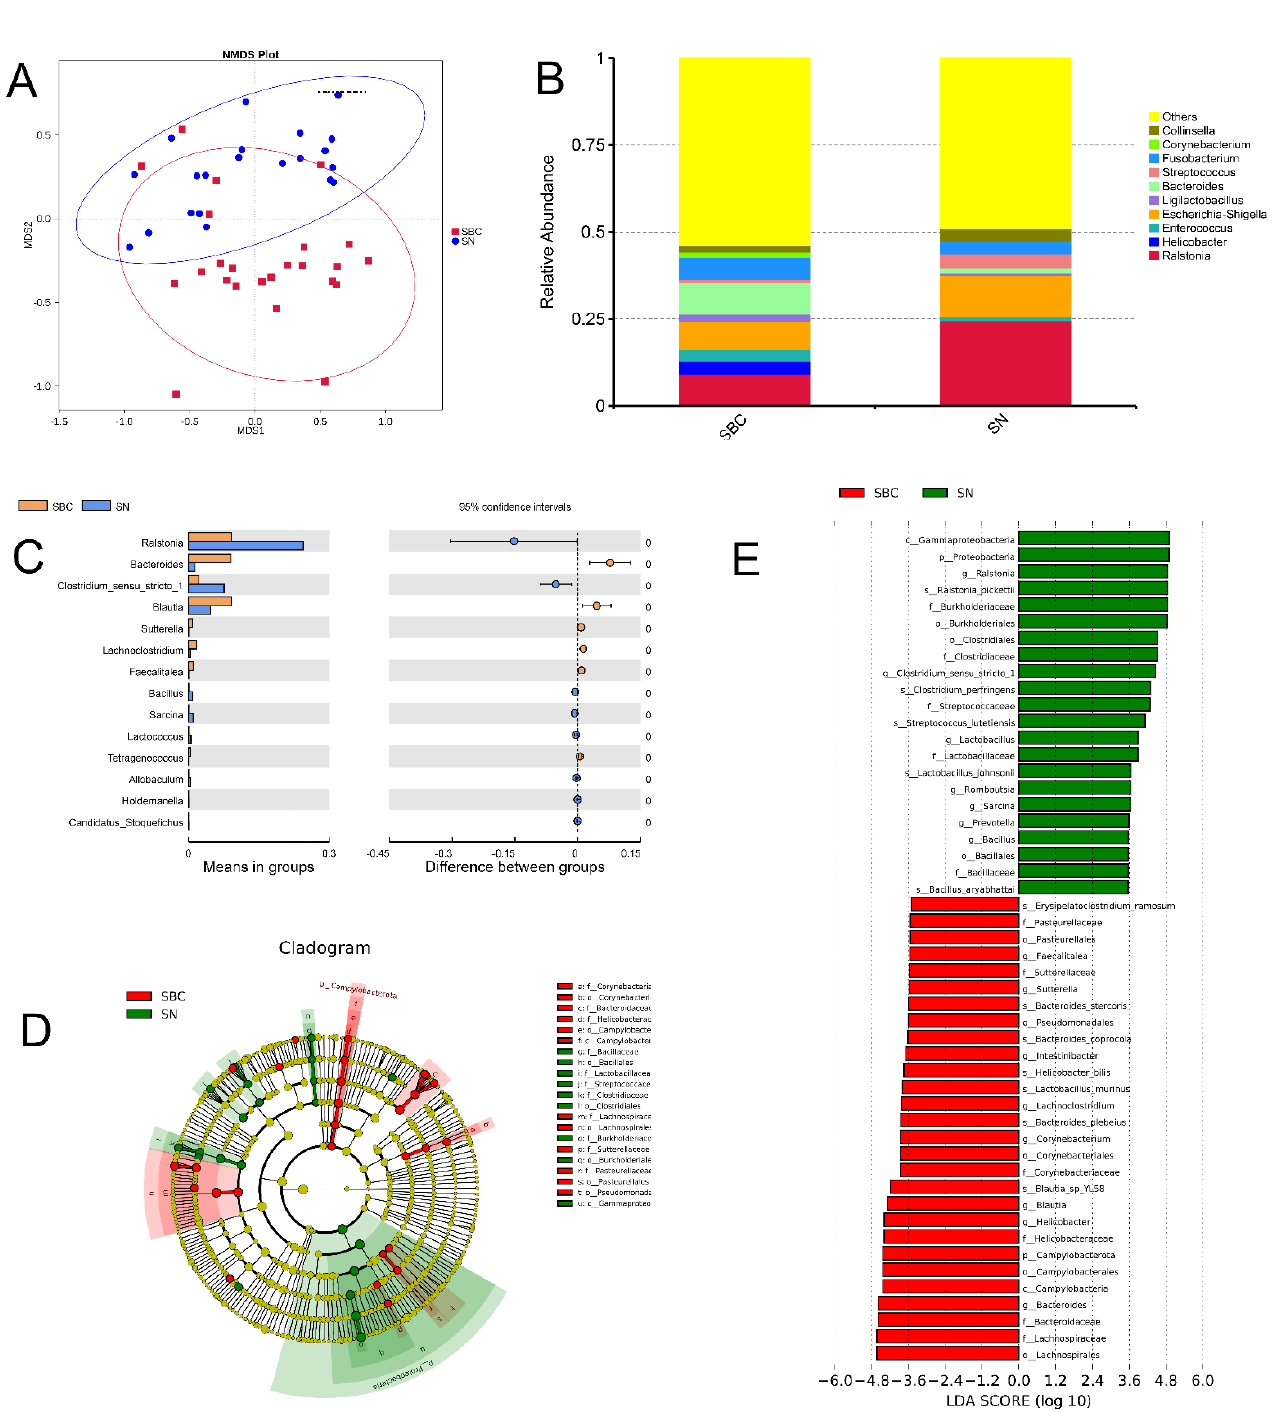
Figure 4. Gut microbial composition and diversity in dogs with canine mammary tumors (SBC group) and healthy dogs (SNN group). ( A ). Beta diversity (the analysis of similarity) of microbial community structures between both SBC and SNN groups: the gut microbiome of SBC group clustered separately from that of the control ONN group; ( B ) The distribution of the top 10 genera detected in fecal samples of dogs with canine mammary tumors; ( C ) The gut microorganisms which had significantly different abundance in SBC and SNN groups at genus level; ( D ) The cladogram of the gut microorganism of SBC and SNN groups; ( E ) The LDA Effect Size (LEfSe) of SBC and SNN groups: it displayed the remarkable species of gut microbiota between both two groups, and its log 10 (LDA score) was greater than